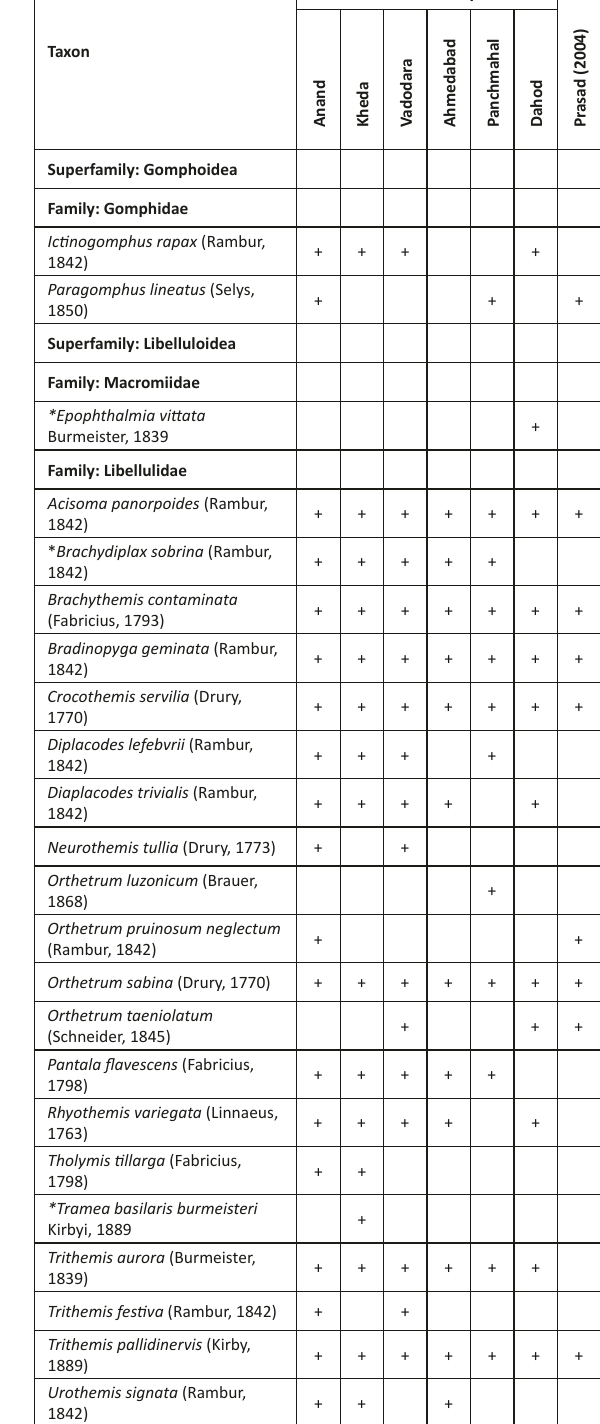
Table 1. A comparison of odonates collected from central Gujarat (present study) with species list of Gujarat by Prasad (2004). Species marked with asterisk (*) are first record for the Gujarat State. Present study Taxon